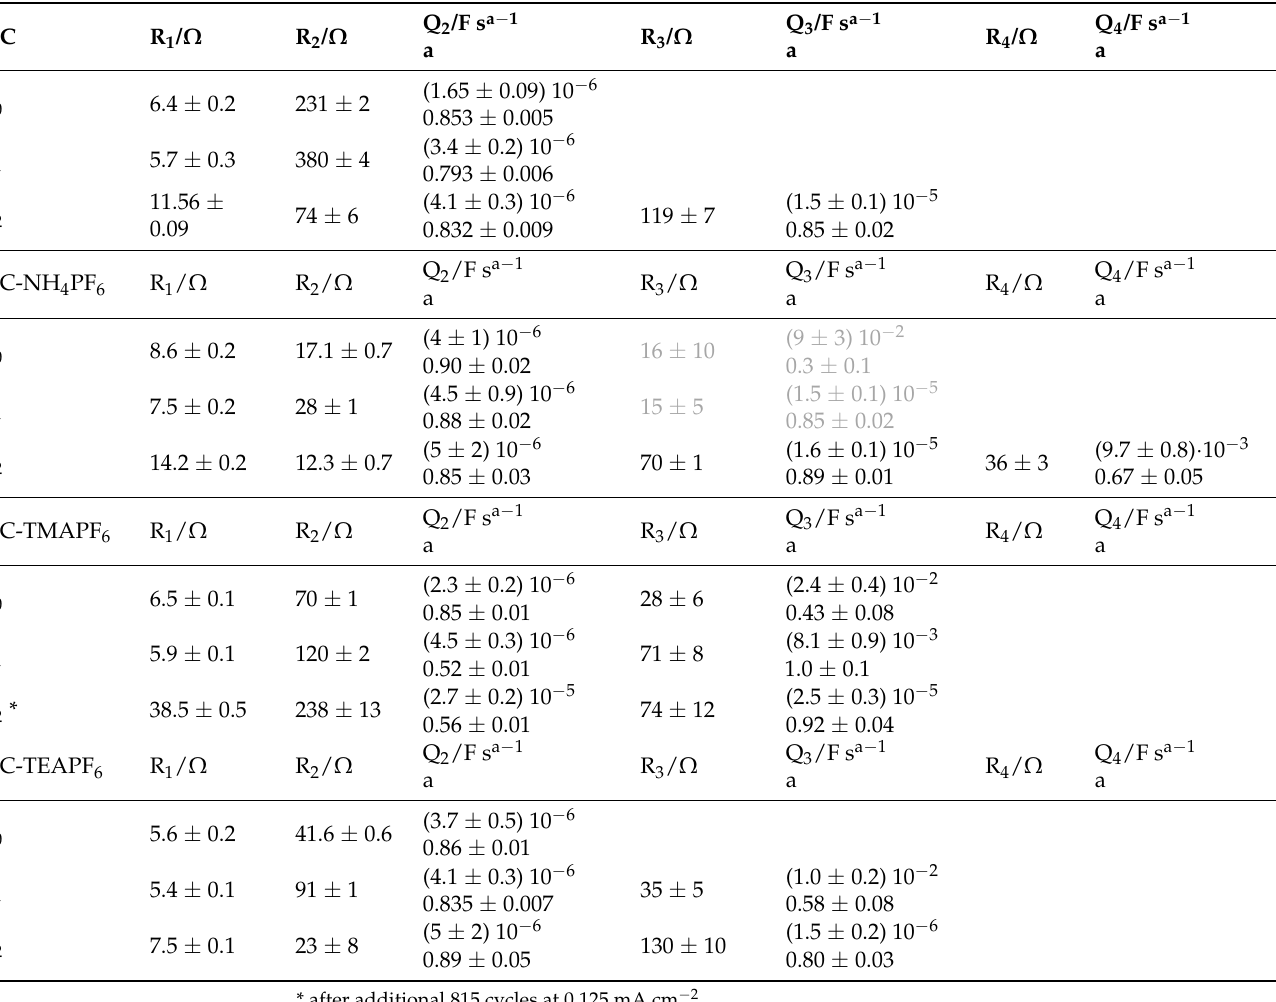
18 of 21 Table A3. Fitting parameters of the impedance spectra over deposition/stripping tests of Li||Li cells